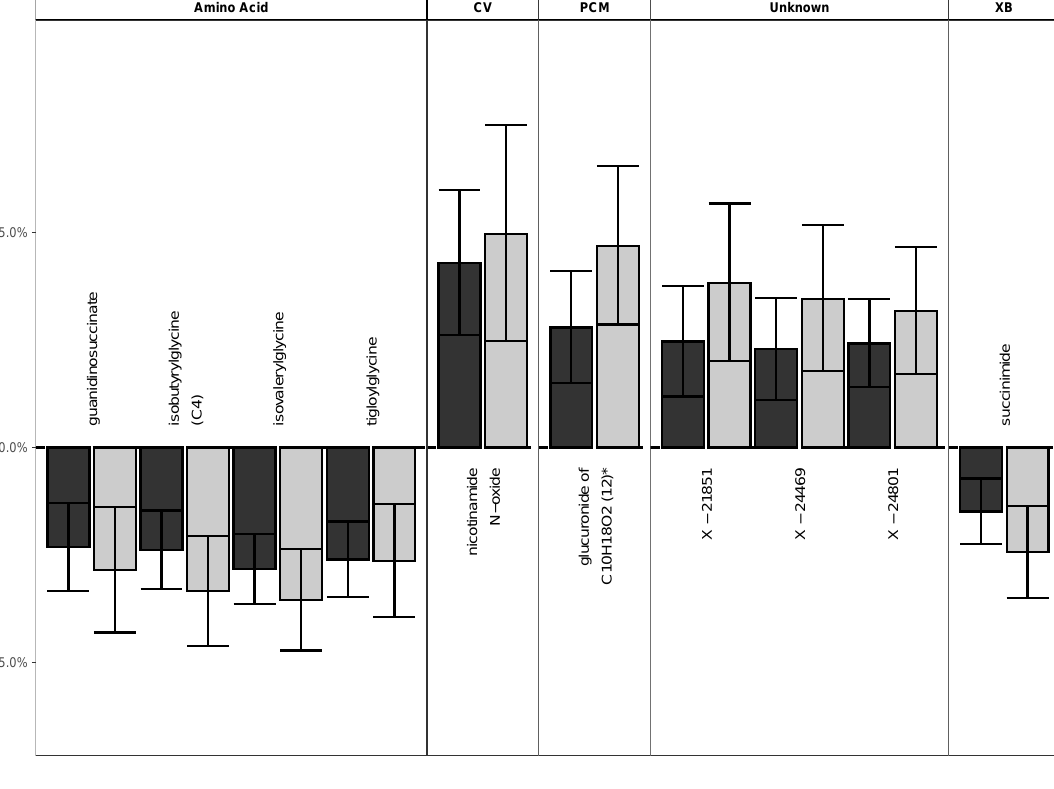
Figure 1. Metabolites associated with body mass index (BMI) and body fat (BF). Estimates are back-transformed linear regression beta coe ffi cients, regressing metabolites on body composition (BMI or BF). BMI is measured in kg / m 2 and body fat in percent. Abbreviations: CV, cofactor and vitamins; PCM: partially characterized molecules; XB: